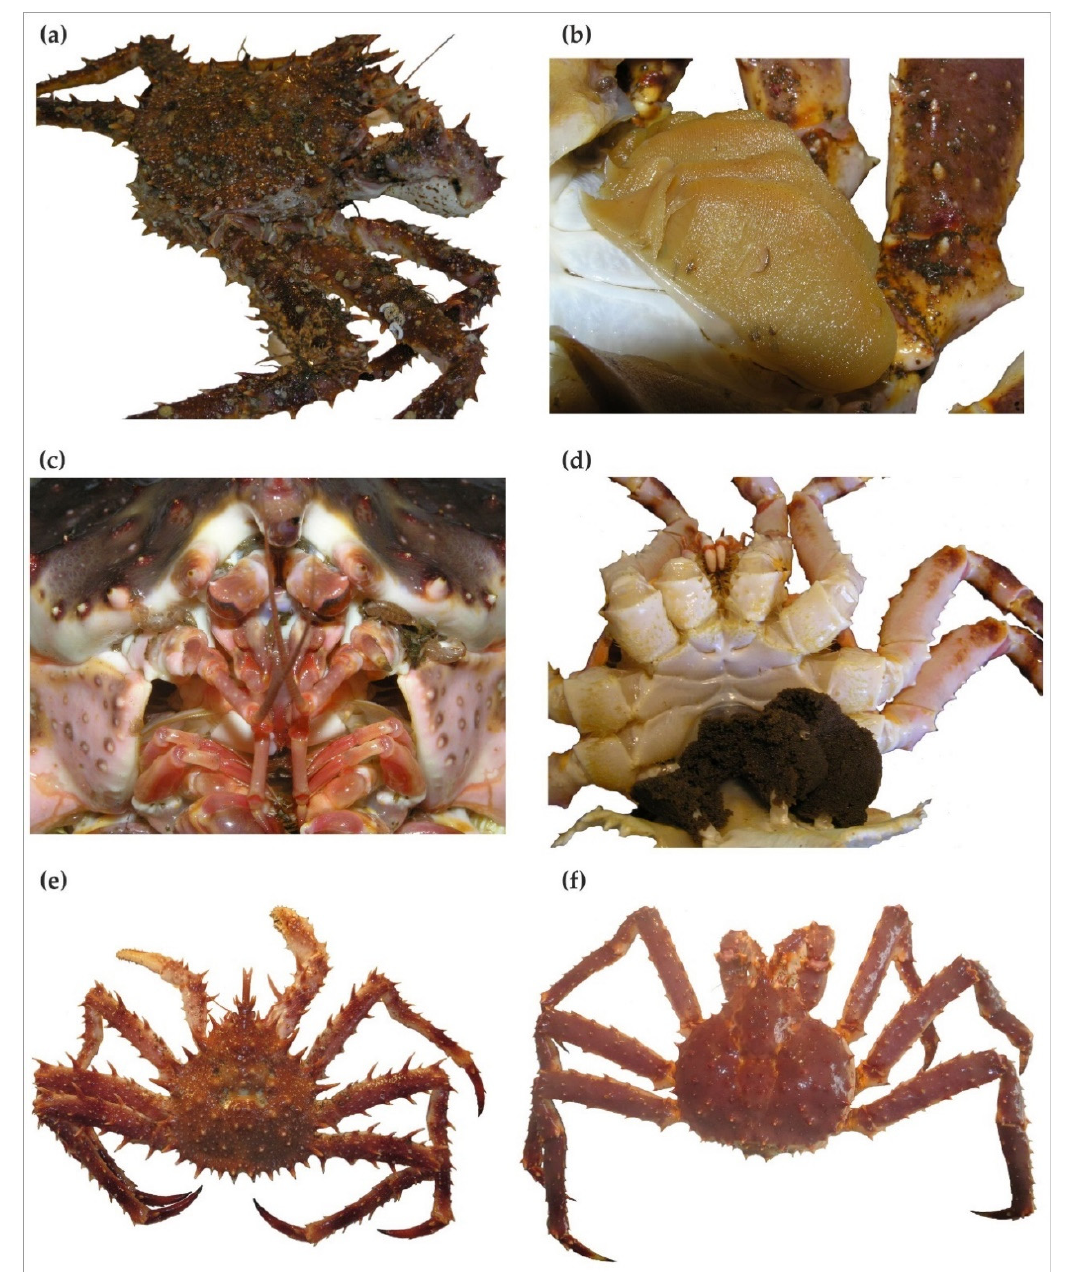
Figure 2. Lithodes maja and Paralithodes camtschaticus . Typical epibiotic community of northern stone crabs ( a ). Symbiotic amphipods, Ischyrocerus commensalis , in the gills ( b ), on the mouthparts ( c ), and on the egg masses ( d ) of red king crabs. Carapaces of a recently molted northern stone crab ( e ) and red king crab ( f ).